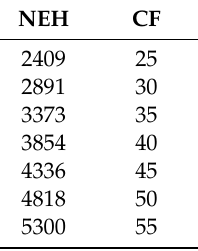
Table 1. Correspondence between net equivalent hours (NEH) at 120 m a.s.l. and capacity factors